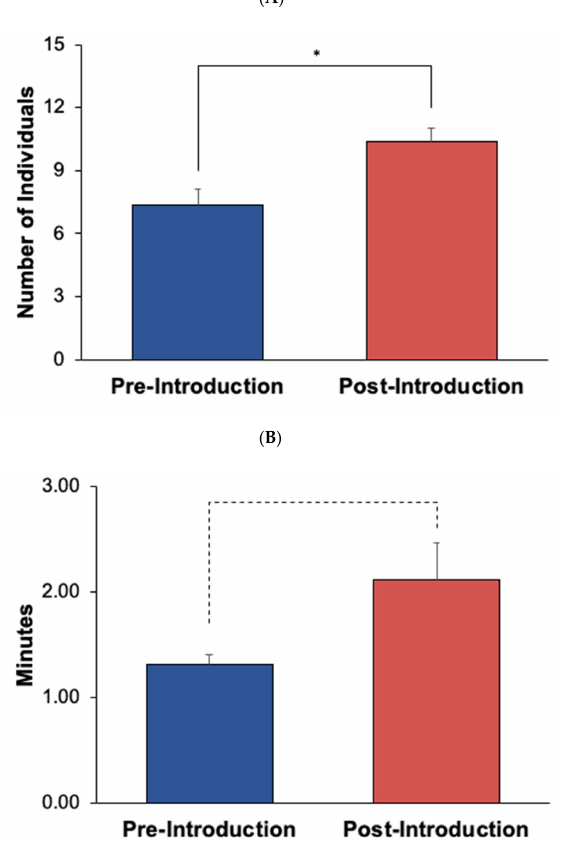
Figure 12. Visitor activity levels for Experiment 2, comparing pre- and post-introduction. ( A ) shows the mean number of individuals (visitor crowd size) in each condition, with standard error of the mean bars. ( B ) shows the average amount of time visitors spent at the exhibit in minutes (visitor length of stay) in each condition, with standard error of the mean bars. Solid lines and asterisk rep ‐ resent statistically significant results in accordance with the Bonferroni correction for Experiment 2 ( α = 0.007). * p ≤ 0.004. Dotted lines represent near significant results ( p < 0.05). Several impacts were seen in both seal and visitor activity as a result of the introduc ‐ tion. Chiidax’s introduction was associated with a significant increase in Flaherty’s Social behaviors and a significant decrease in Flaherty’s Stereotypic behaviors. Both of these re ‐ sults are suggestive of a positive welfare effect associated with the introduction. There was a significant increase in crowd size at the Northern fur seal exhibit even though there was not a significant increase in overall visitor attendance, which suggests increased vis ‐ itor interest in the northern fur seals as a result of the new animal introduction. Finally,